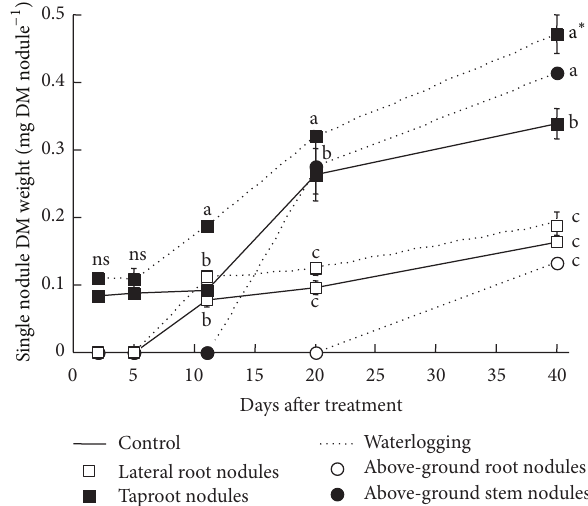
Figure 3: Changes in root dry matter (DM) weight in experiment 2. Symbols with different letters within the same investigation date and treatment show significant differences ( 𝑃 < 0.05 ). ∗ Significant difference ( 𝑃 < 0.05 ) in the total root DM weight at the same day.